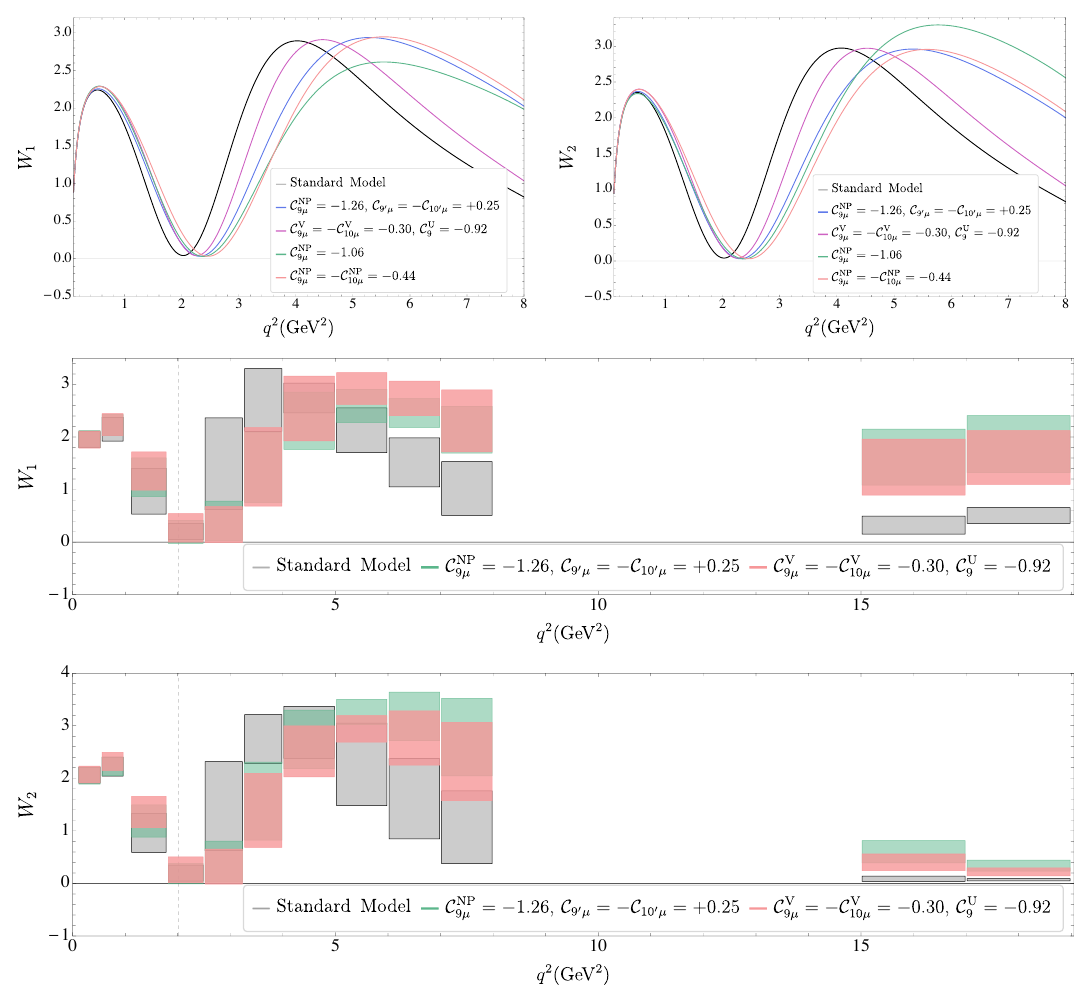
Figure 5 . SM and NP predictions for the observables W 1 and W 2 as continuous functions of q 2 and binned in q 2